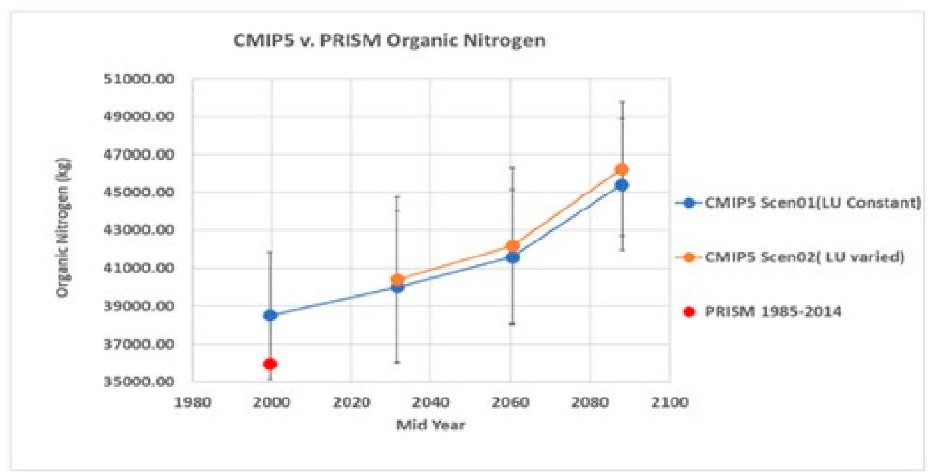
Figure 6. PRISM vs. average of 20 CMIP5 GCMs organic nitrogen (2018–2100).